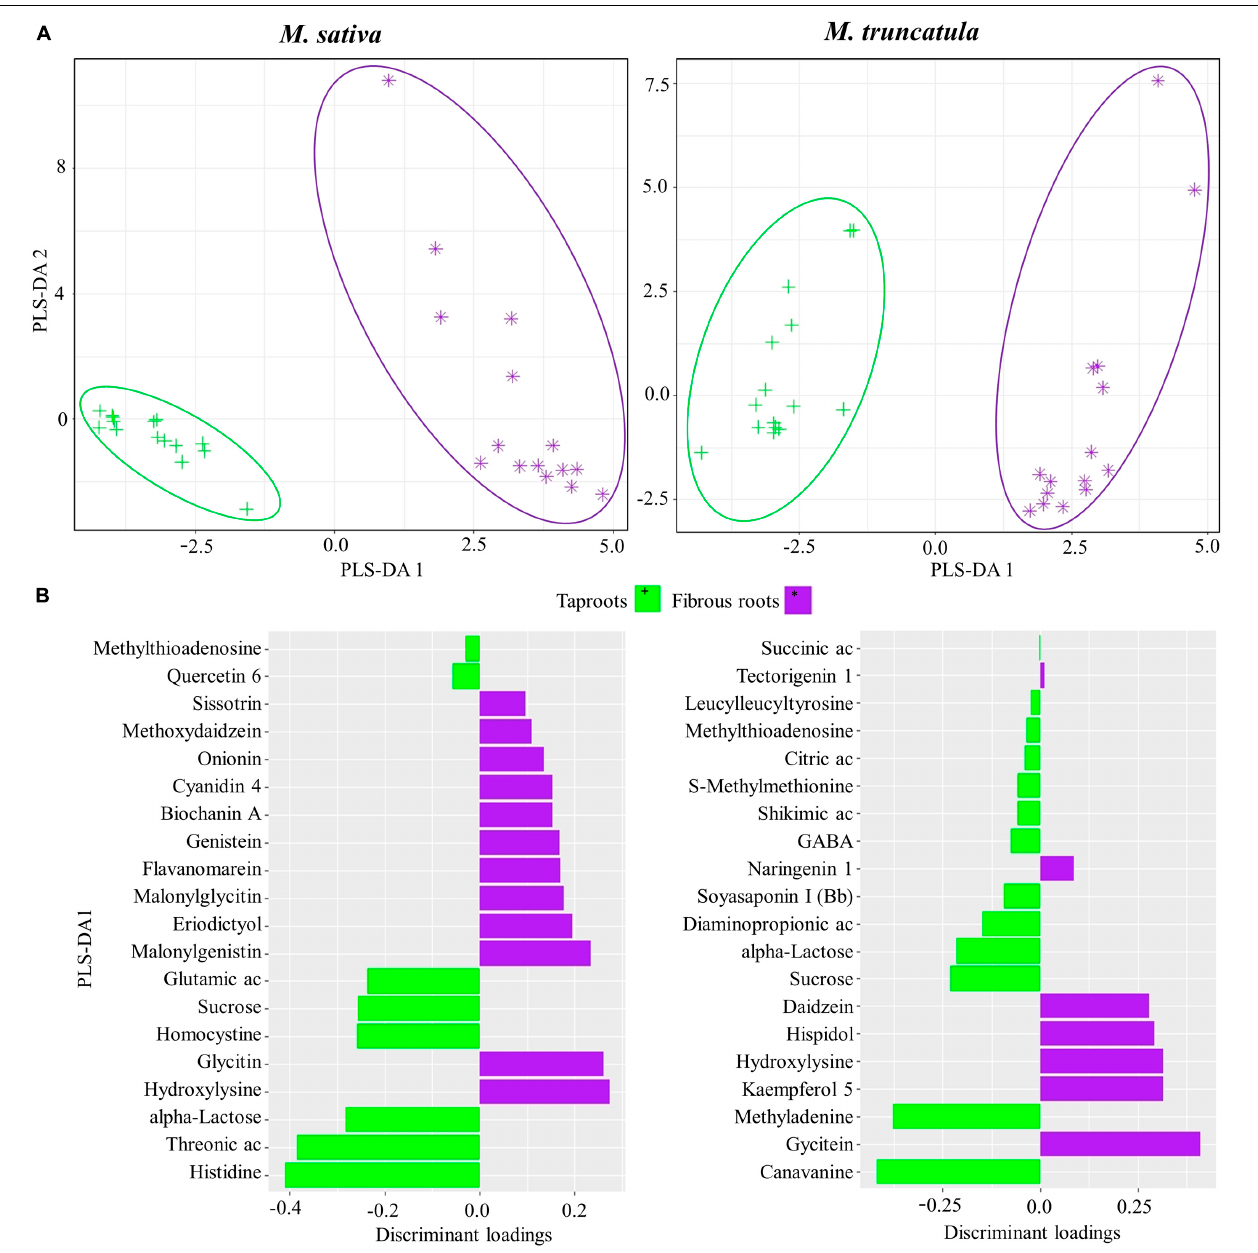
FIGURE 3 | Identification of metabolites discriminating root system types. (A) Partial least square discriminant analysis (PLS-DA) of metabolites for Medicago sativa (left panel) and M. truncatula (right panel). (B) Metabolites with the highest discriminant loadings for taproots (tapRs) and fibrous roots (fibRs). Ac, acid; GABA, γ -aminobutyric